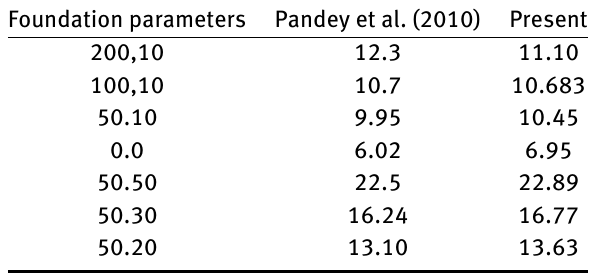
Table 1: Comparison for effect of foundation parameters on the ther- mal buckling response of [45/-45/45/-45/45/-45] square